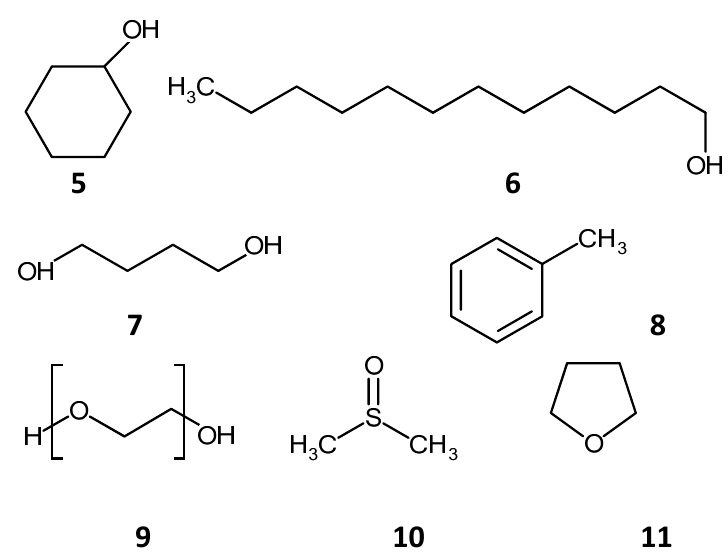
Figure 3. Chemical structures of commonly used porogenic solvents, ( 5 ) cyclohexanol; ( 6 ) dodecanol; ( 7 ) 1,4 butane-diol; ( 8 ) toluene; ( 9 ) poly ethylene glycol; ( 10 ) dimethyl sulfoxide; ( 11 ) Tetrahydrofuran.